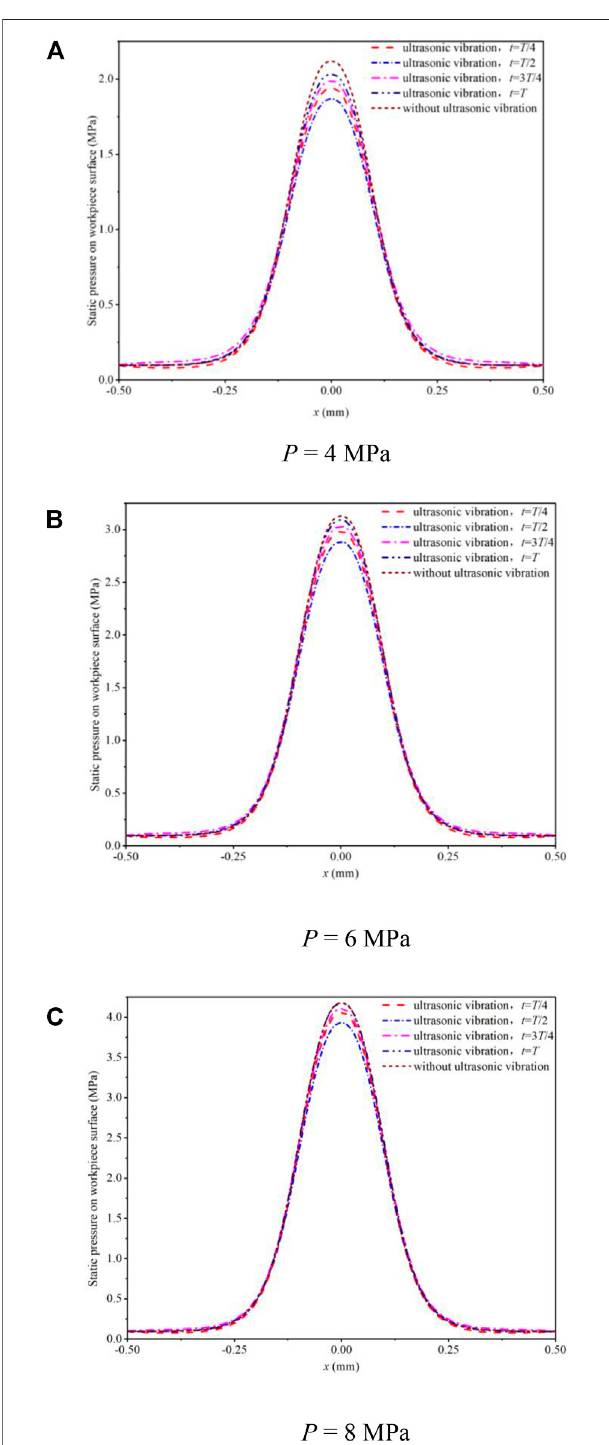
FIGURE 2 | The distribution of the static pressure on the surface of the workpieceintheradialdirection. (A) P =4 MPa, (B) P =6 MPa, (C) P =8